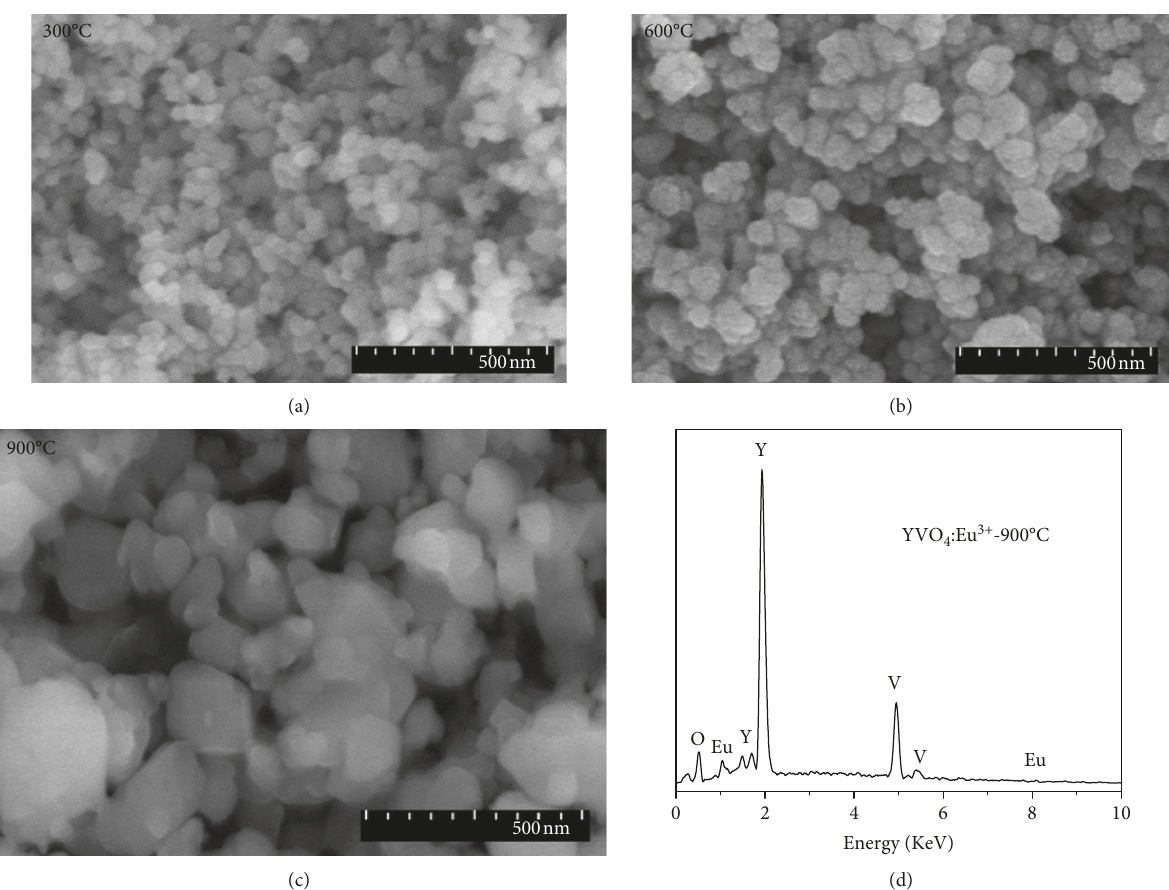
Figure 7: FE-SEM micrographs of YVO 3+ nanoparticles at different annealing temperatures and corresponding EDX spectrum of 4 :Eu samples annealed at 900 ° C (in